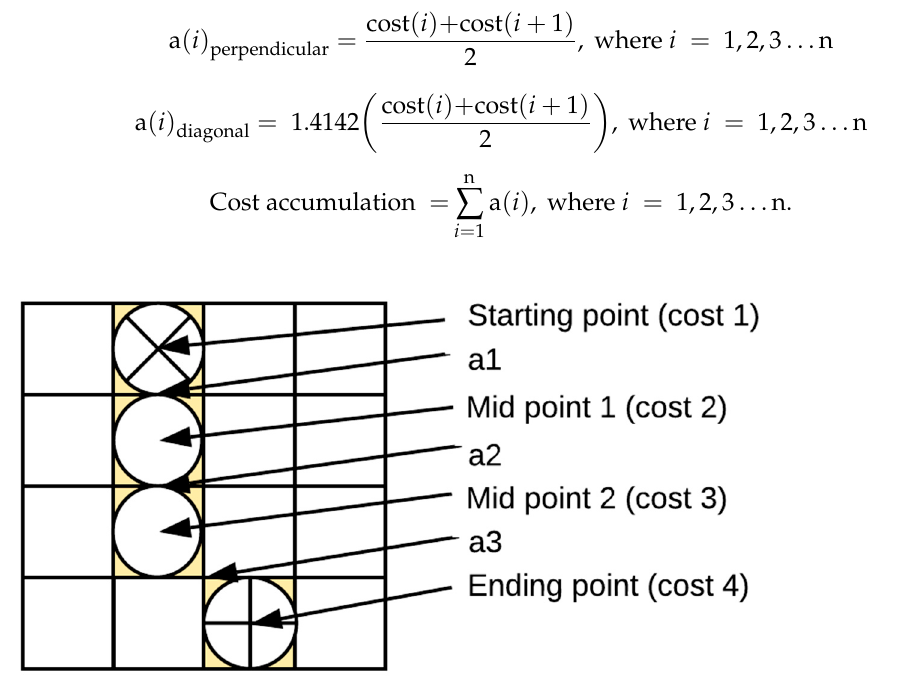
Figure 6. Cost distance accumulation algorithm demonstrating movement from a starting point (source) to an ending point through a path that incorporates perpendicular and diagonal move- ment. Equations (1)–(3) illustrate the computation of the costs and accumulation.